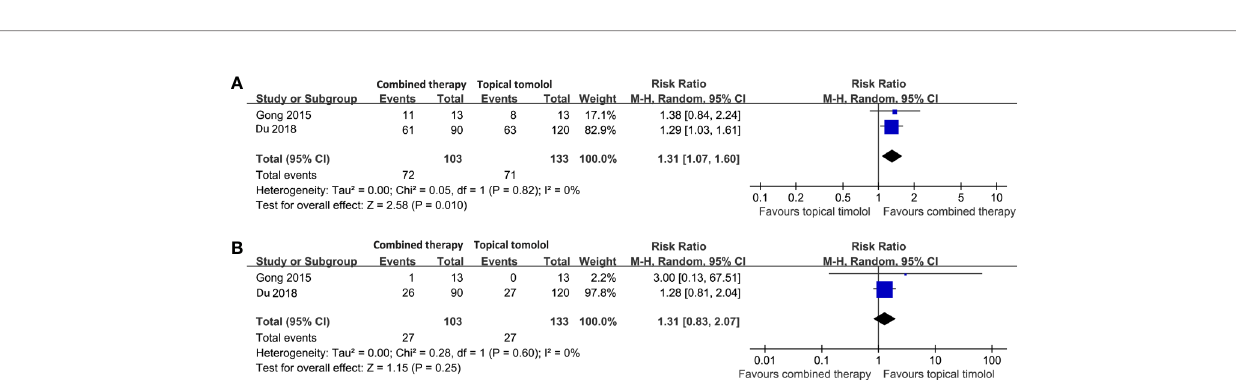
FIGURE 4 | Forest plots for the meta-analyses comparing the ef fi cacy and safety outcomes between the combined therapy and topical timolol for treating IH. (A) , response rate after treatment; (B) , incidence of adverse events.